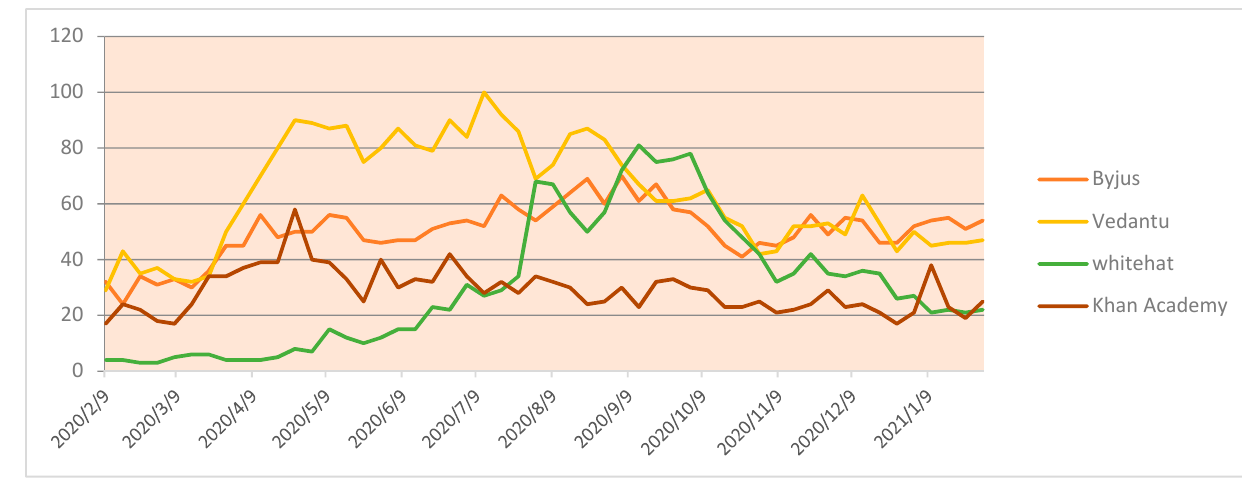
Figure 4. School-level online platforms.